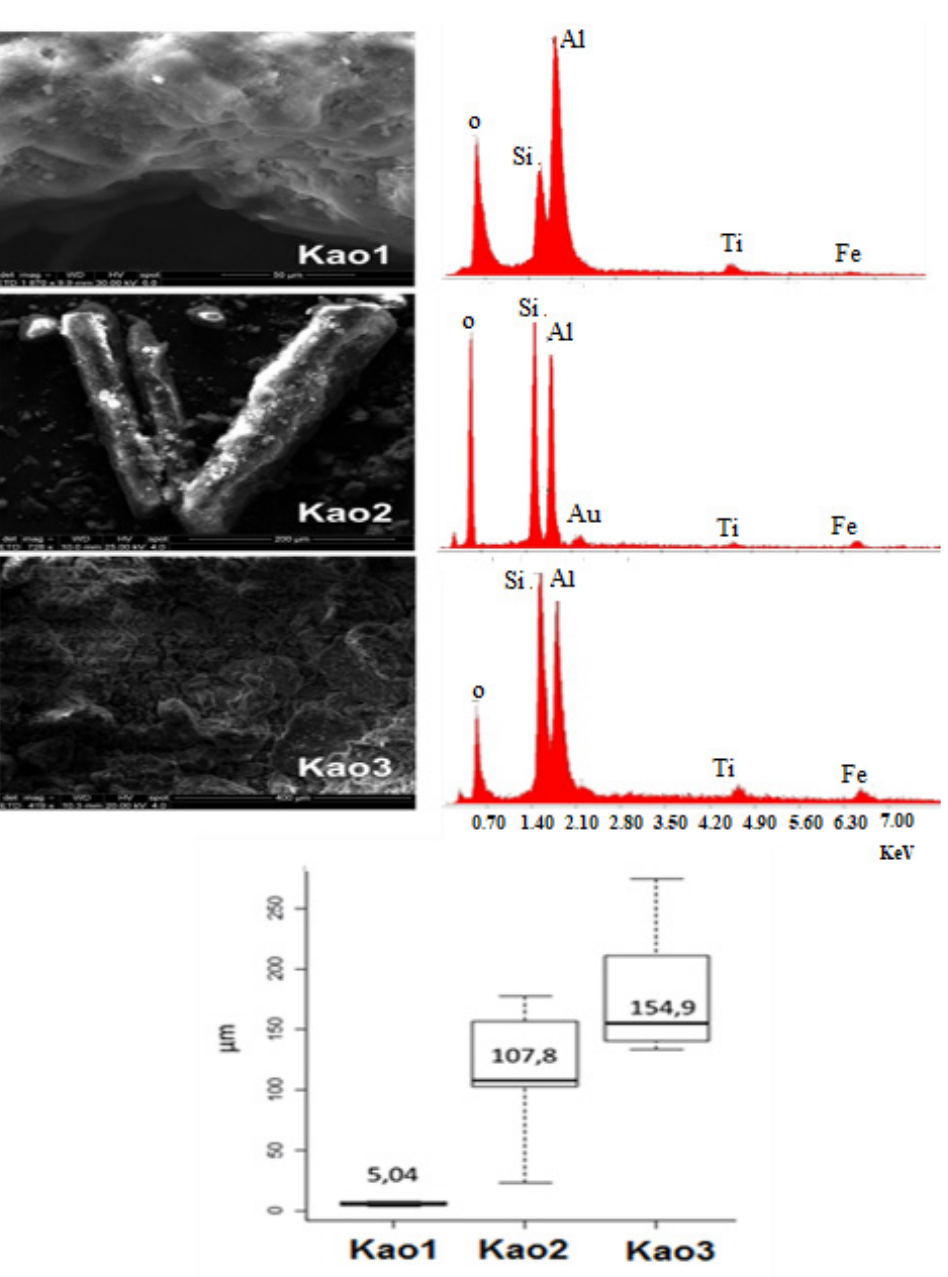
Figure 3 - Secondary electron images of scanning electron microscopy and EDS spectrum of the Kao1 and Kao2 Kao3